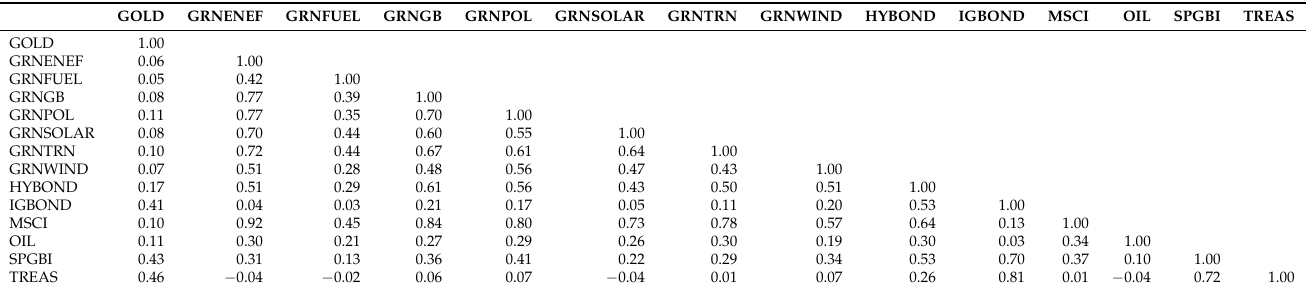
on the particular green equity sub-sector considered. More precisely, these correlations range from 0.13 for the Fuel Cell sub-sector to 0.41 for the Pollution Prevention sub-sector. This relatively low correlation suggests that overall green bonds and green equities do not seem to be driven by the same factors. In fact, the green equity sector indices tend to be more significantly correlated among themselves and the general stock market than with the green bond index. Furthermore, a very low positive correlation (0.10) is observed between green bonds and crude oil prices. Likewise, green stocks exhibit a relatively low positive correlation (ranging from 0.19 to 0.30) with crude oil, though more pronounced than in the case of green bonds. Lastly, it should be mentioned that green stocks are in general weakly correlated with Treasury and investment-grade corporate bonds and with gold. Table 2. Correlation matrix. This table reports the values of the Pearson linear correlation coefficient between all pairs of variables over the full sample